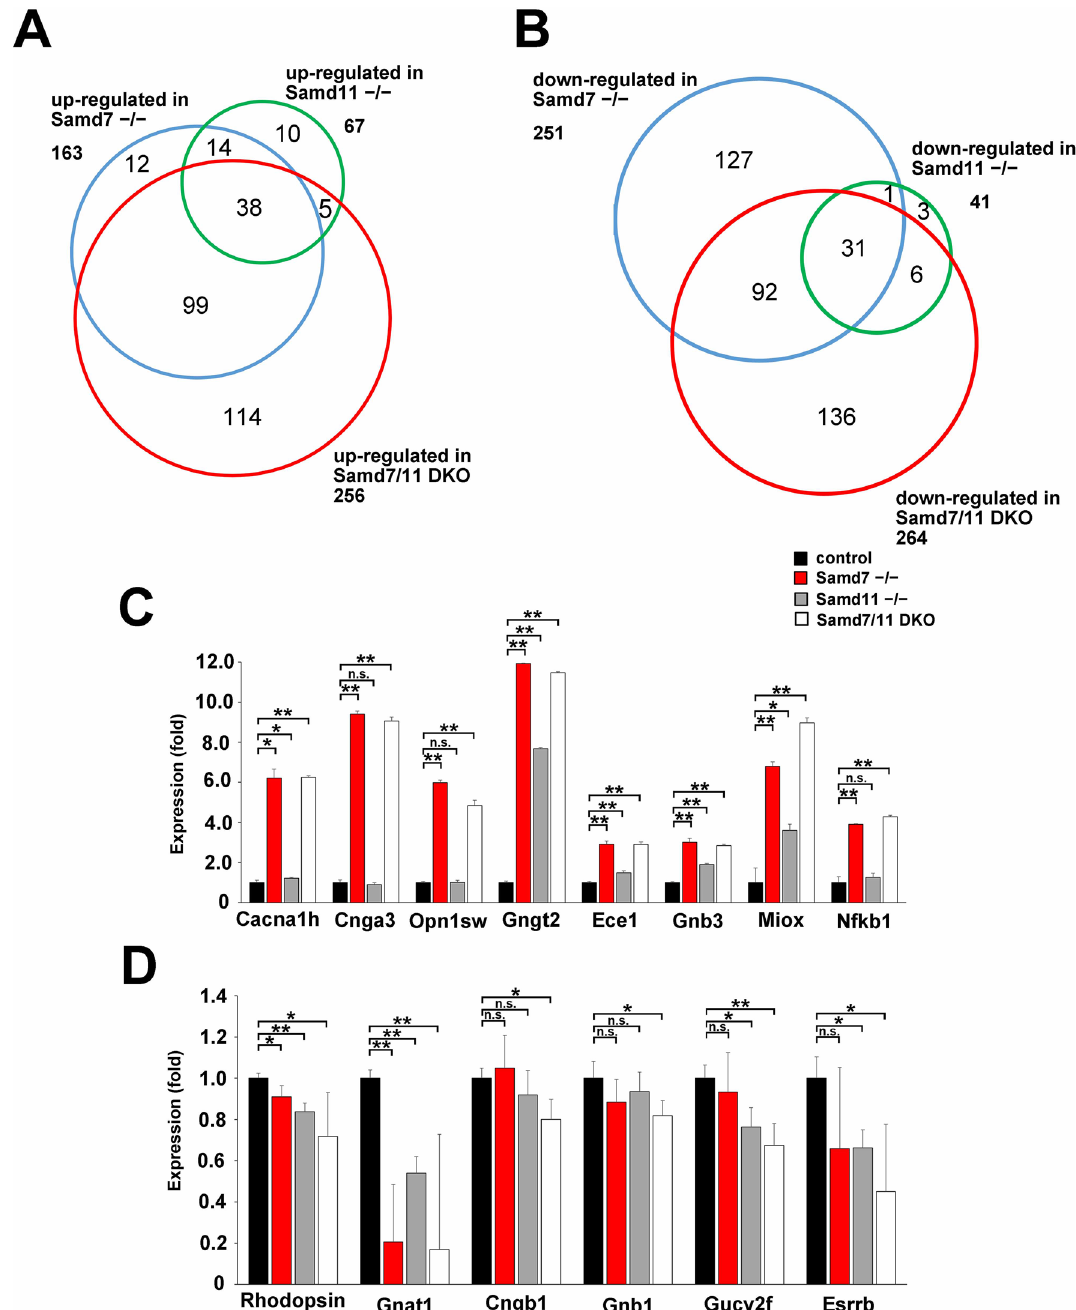
Figure 4. Retinal gene expression profiles in Samd7 −/− , Samd11 −/− , and Samd7/11 DKO mice. (A,B) Venn diagram of up-regulated (A) and down-regulated (B) genes in Samd7 −/− , Samd11 −/− , and Samd7/11 DKO retinas compared to the genes expressed in the control retina. Microarray analysis was performed using mRNA from control, Samd11 −/− , and Samd7/11 DKO retinas at P12. The number of up-regulated genes (signal log ratio greater than + 1.0) in the Samd11 −/− , retina (green circle) and Samd7/11 DKO retina (red circle) was 67 and 256, respectively, compared to the control retina. The number of down-regulated genes (signal log ratio less than − 0.5) in the Samd11 −/− retina (green circle) and Samd7/11 DKO retina (red circle) were 41 and 264, respectively, compared to the control retina. (C,D) The up-regulation (C) and down-regulation (D) of selected genes from the microarray analysis was confirmed by qRT-PCR with mRNA from control, Samd11 −/− , Samd7 −/− , and Samd7/11 DKO retinas at P12. Error bars indicate mean ± SD, n = 3 per group. Student’s t-test; ** P < 0.01, * P < 0.05, n.s not